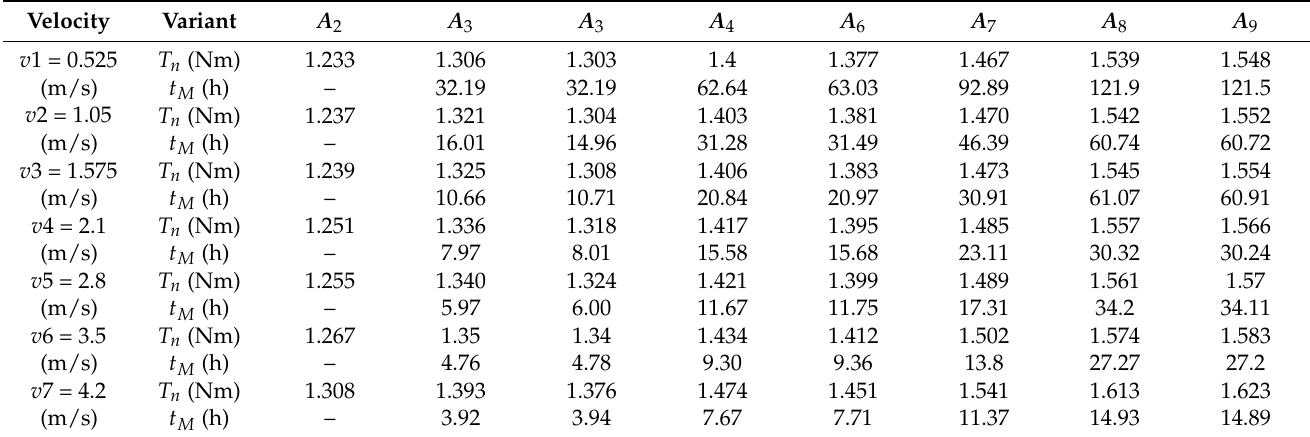
Table 3. Values obtained in course of conduction the